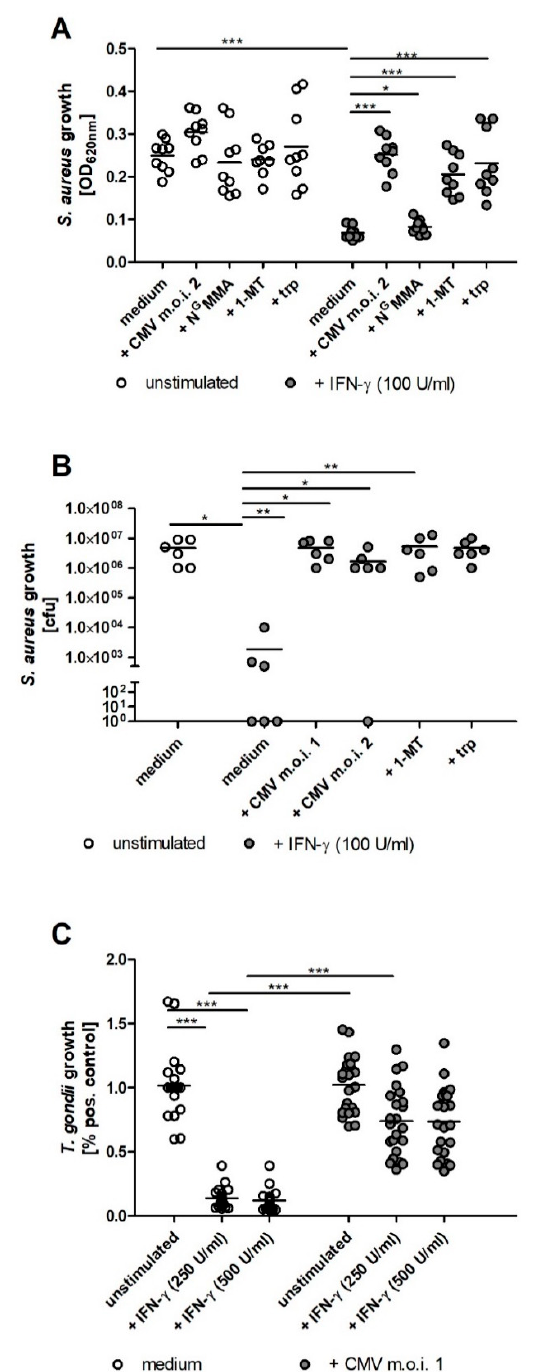
Figure 2. IDO1-mediated antibacterial and antiparasitic effects are lost in hRPE cells upon CMV infection. 3 × 10 4 hRPE cells were stimulated in 96-well plates with indicated amounts of human IFN- γ (0 to 500 U/mL) in the presence of CMV (m.o.i. 1 or 2), N G MMA (100 µ g/mL), 1-methyl-tryptophan (1-MT; 1.5 mM), or L -tryptophan (trp; 100 µ g/mL). After 72 h the cell culture supernatants were harvested and infected with Staphylococcus aureus (10–100 cfu/well) ( A , B ) or Toxoplasma gondii (3 × 10 4 ME49 tachyzoites per well) ( C ). S. aureus growth was detected by measurement of the optical density at 620 nm after 16 h ( A ) or by counting the colony forming units (cfu; B ). T. gondii growth was measured after three days using the 3 H-uracil incorporation method. Data are given as mean ± SEM of three ( A , B ) or eight ( C ) experiments, each performed in triplicate. Significant differences to the unstimulated or uninfected group were marked with asterisks (n.s. = not significant; * p ≤ 0.05; ** p ≤ 0.001 and *** p ≤ 0.0001). The nonparametric Mann–Whitney U test was used.